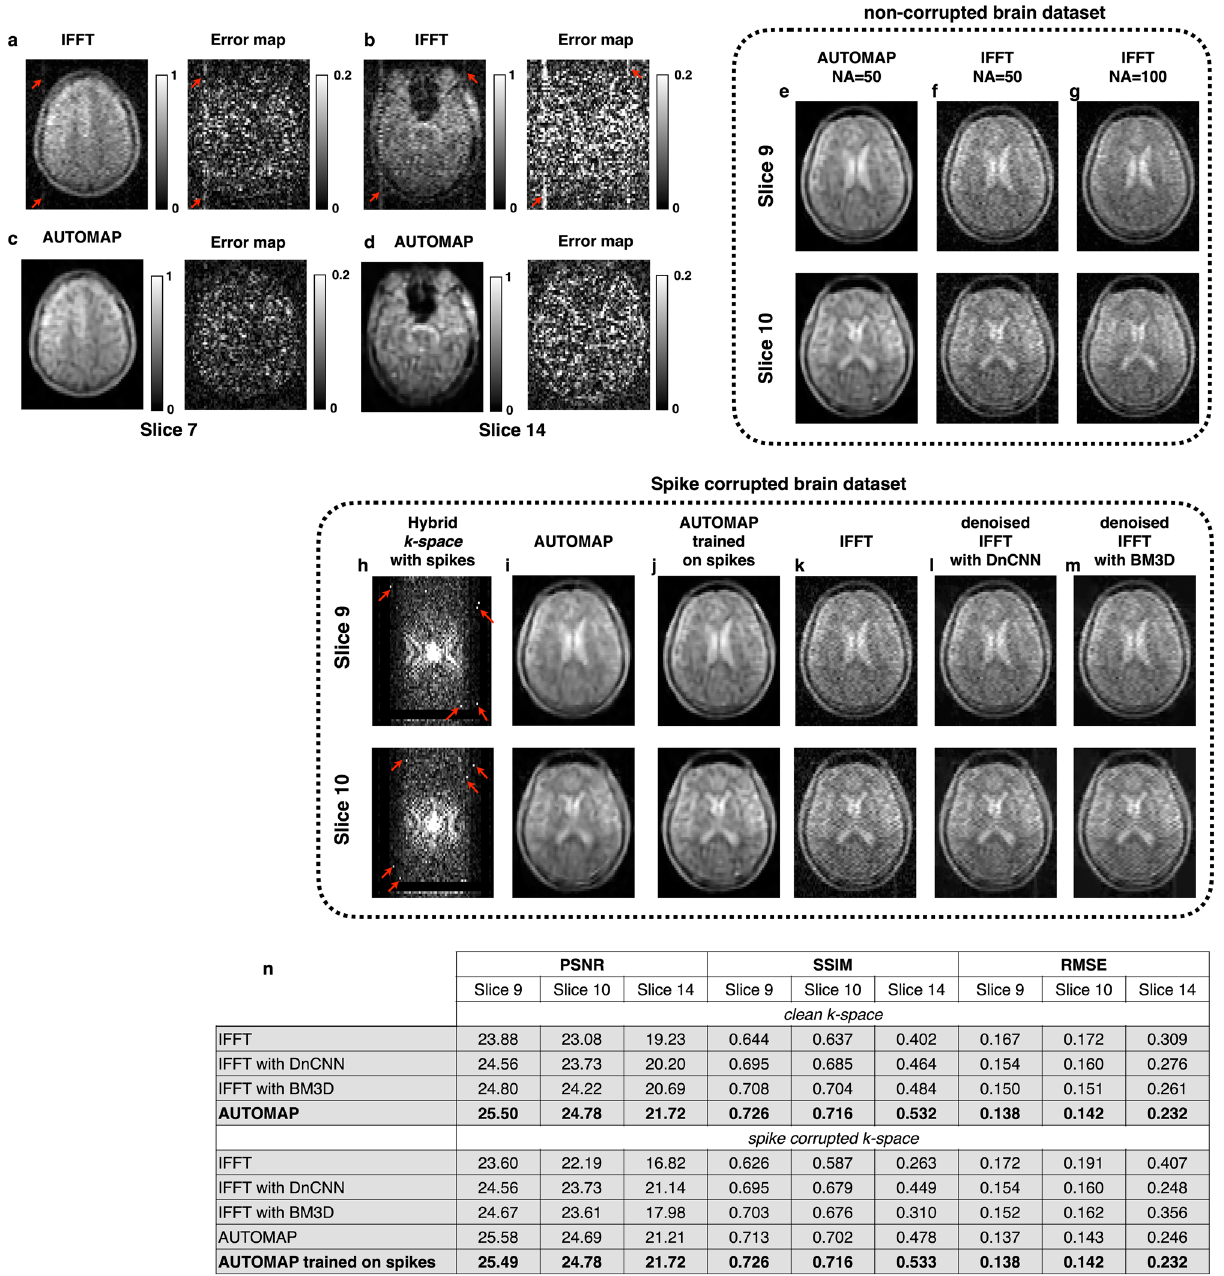
Figure 4. Artifacts: ( a – d ) Elimination of hardware artifacts at 6.5 mT—Two slices from a 3D bSSFP (NA = 50) are shown. When reconstructed with IFFT ( a , b ), a vertical artifact (red arrows) is present across slices. When the same raw data was reconstructed with AUTOMAP ( c , d ), the artifacts are eliminated. The error maps of each slice with respect to a reference scan (NA = 100) is shown for both IFFT and AUTOMAP reconstruction. ( e – g) Uncorrupted k -space (NA = 50) was reconstructed with AUTOMAP ( e ) and IFFT ( f ). The reference NA = 100 scan is shown in ( g ). (h – m ) AUTOMAP reconstruction of simulated k -space artifacts. Two slices of the hybrid k -space from the 11-min (NA = 50) brain scan was corrupted with simulated spikes ( h ). In ( i ), the data was reconstructed with AUTOMAP trained on the standard corpus of white Gaussian noise corrupted brain MRI images. In ( j ), the k -space data was reconstructed with AUTOMAP with a training corpus of k -space data including variable number of random spikes. IFFT reconstructed images are shown in ( k ), where the spiking artifacts are clearly seen. Denoised IFFT with DnCNN reconstructed images are shown in ( I ) and denoised IFFT with BM3D reconstructed images are shown in ( m ). ( n ) The table summarizes image quality metrics for the reconstruction task of the three slices, both with- and without spike corruption. PSNR, SSIM and RMSE were evaluated for reconstruction using IFFT, denoised IFFT with either DnCNN or BM3D, and AUTOMAP trained on either the standard Gaussian noise-corrupted corpus or on a spike- and Gaussian noise-corrupted